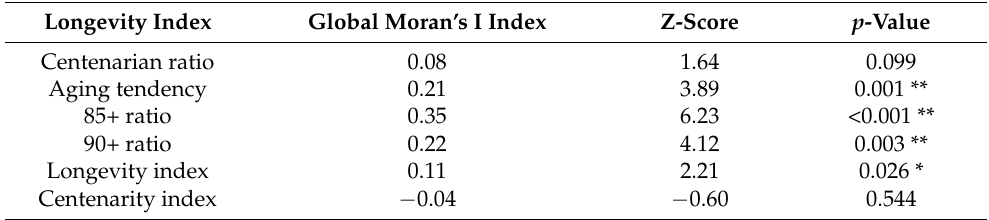
Table 3. Synthesis of global Moran’s I